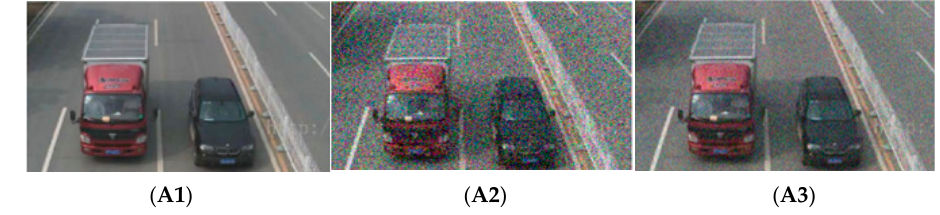
Figure 12. Vehicle images: model performance trained with 64 × 64 image size. ( A1 ) The original image; ( A2 ) the noisy image; ( A3 ) denoised image with σ = 15 .